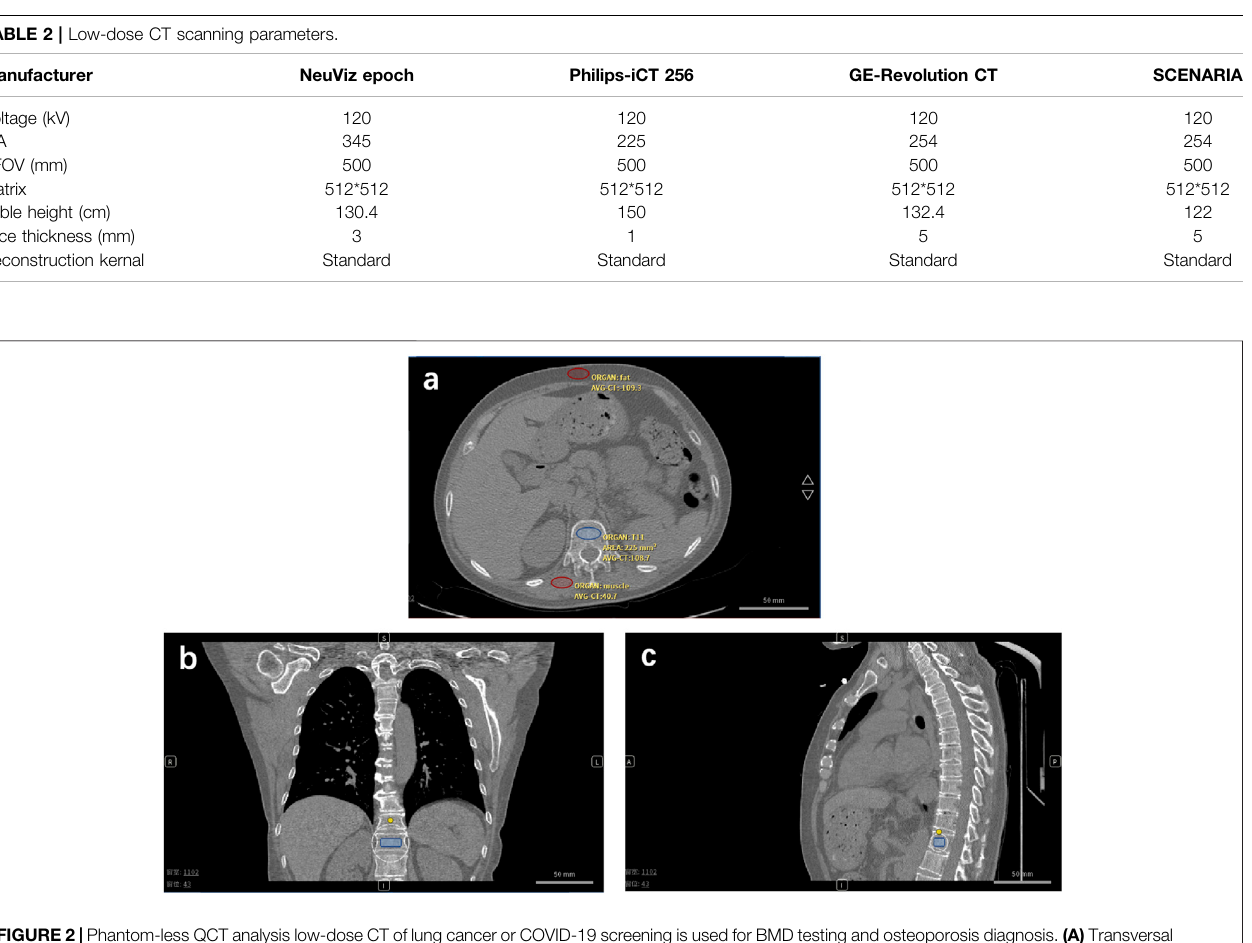
FIGURE 2 | Phantom-less QCT analysis low-dose CT of lung cancer or COVID-19 screening is used for BMD testing and osteoporosis diagnosis. (A) Transversal plane, (B) coronal plane, and (C) sagittal plane of CT image of one enrolled patient. Red ovals represent the muscle and fat ROI. The blue symbol represents the trabecular